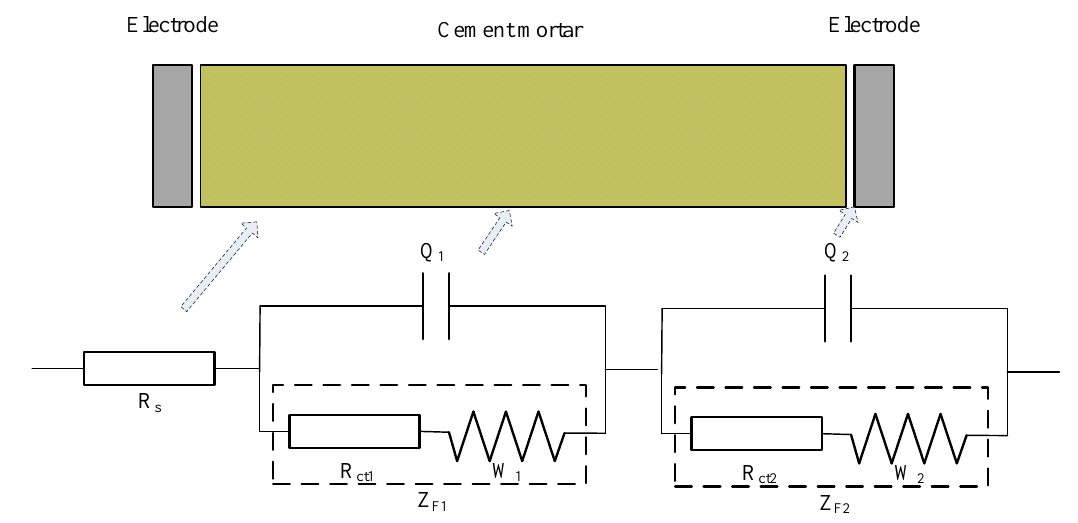
Figure 4. The equivalent circuit model proposed to investigate the cement mortar with carbonation